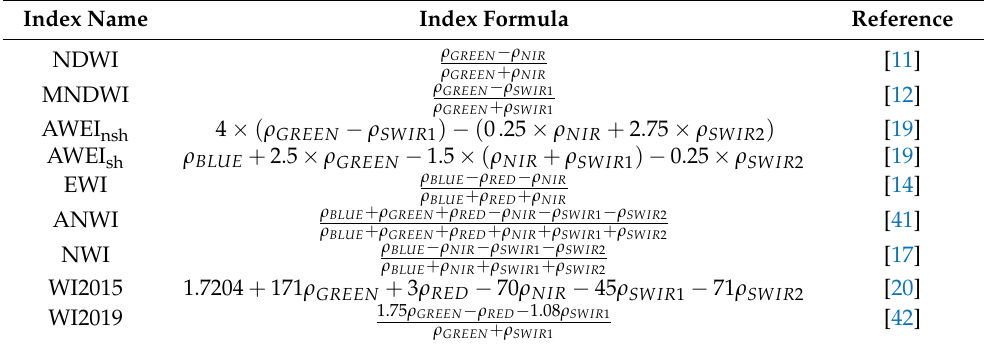
Table 1. Main water index calculation